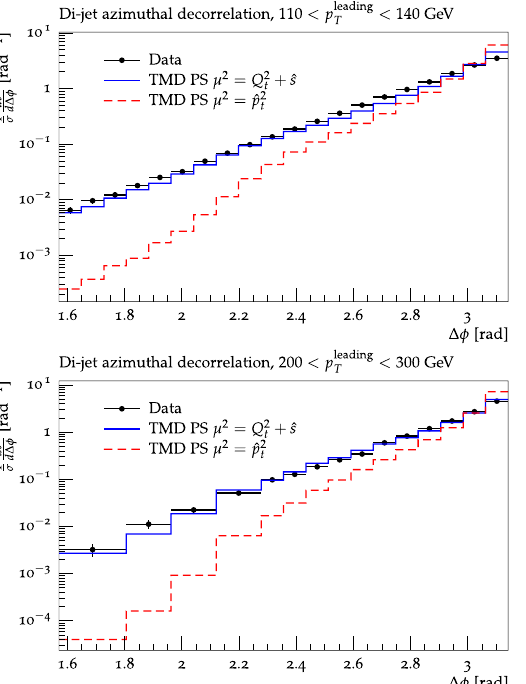
Fig. 7 (cid:4)φ distribution as measured by [43] for different regions of p leading t . The data are compared with predictions using off-shell 2 → 2 matrix elements with TMD parton densities, an initial state TMD par-